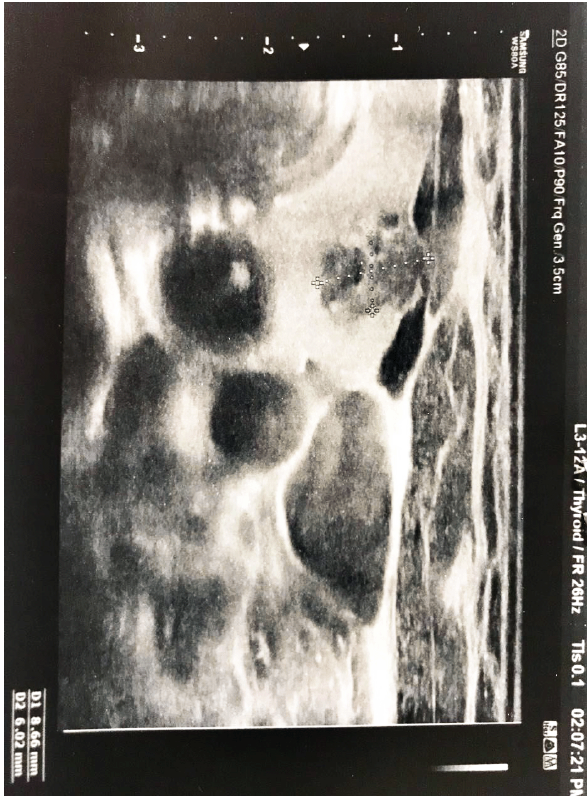
Figure 1: Thyroid ultrasonography showed a large lobulated cystic lesion in the left thyroid